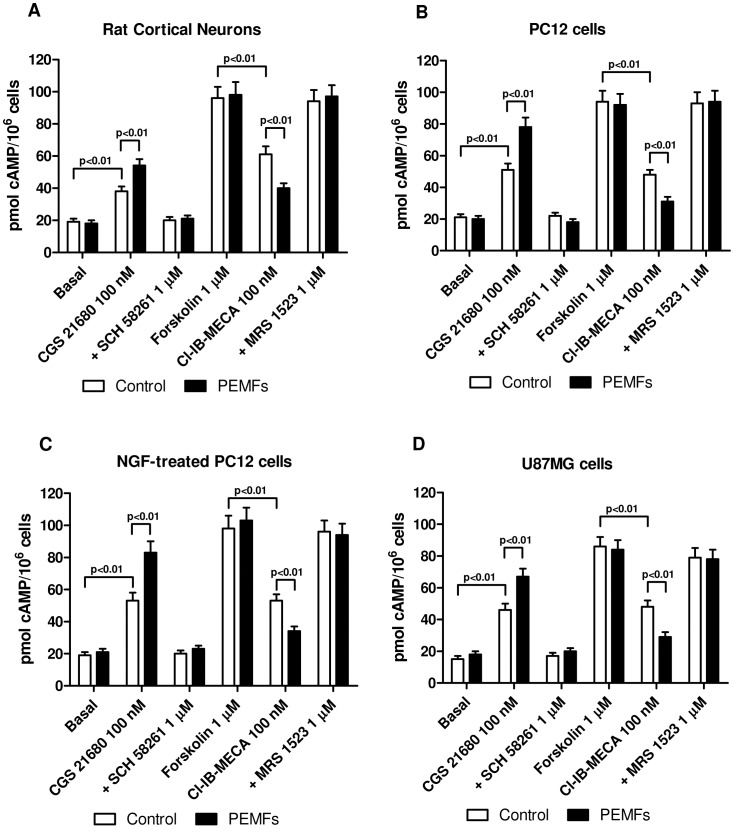
cAMP modulation by PEMFs up-regulated A2A and A3ARs.Effect of a well-known A2AAR agonist and antagonist (CGS 21680, 100 nM; SCH 58261, 1 µM) or A3AR agonist and antagonist (Cl-IB-MECA, 100 nM; MRS 1523, 1 µM) in rat cortical neurons, untreated or NGF-treated PC12 cells and U87MG cells in the absence or in the presence of PEMFs on cAMP production. Values are the mean (n = 6) ± SEM.